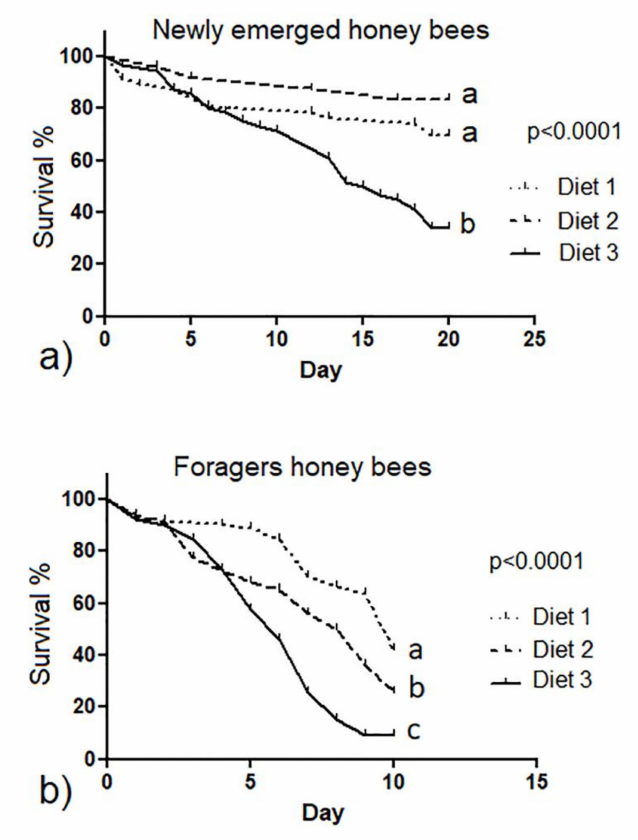
Figure 2. Survival rate of newly emerged ( a ) and forager honey bees ( b ) fed with control and experimental diets (diet 1, diet 2 and diet 3 with 0.3%, 1.7% and 7.7% of protein content, respectively). Different letters indicate statistical significance ( p < 0.0001) by Kaplan–Meier